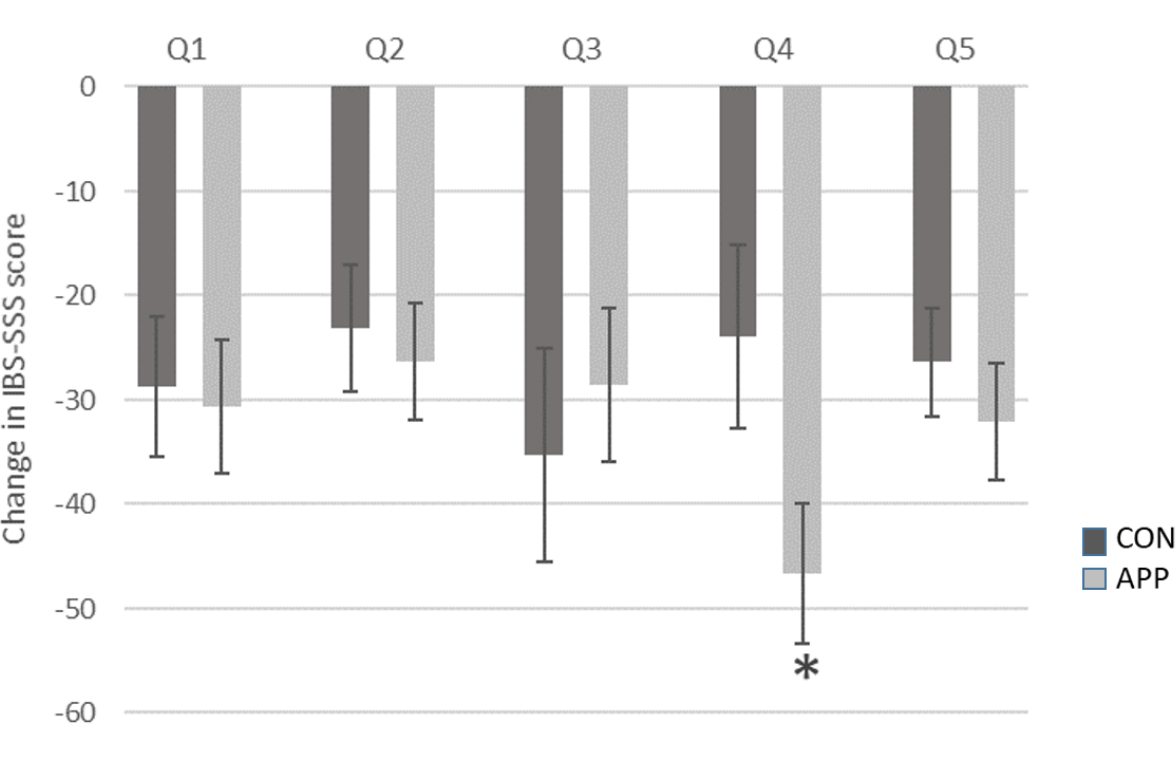
Figure 2. Thirty-day change (mean±SD) in IBS-SSS scores by question. APP: experimental group (access to artificial intelligence dietary mobile app); CON: control group; IBS-SSS: irritable bowel syndrome symptom severity scale; Q1: abdominal pain severity; Q2: abdominal pain frequency; Q3: abdominal pain distension severity; Q4: bowel habit dissatisfaction; Q5: quality of life interference due to the aforementioned symptoms. *Significant difference between CON and APP groups ( P =.05, Mann-Whitney U